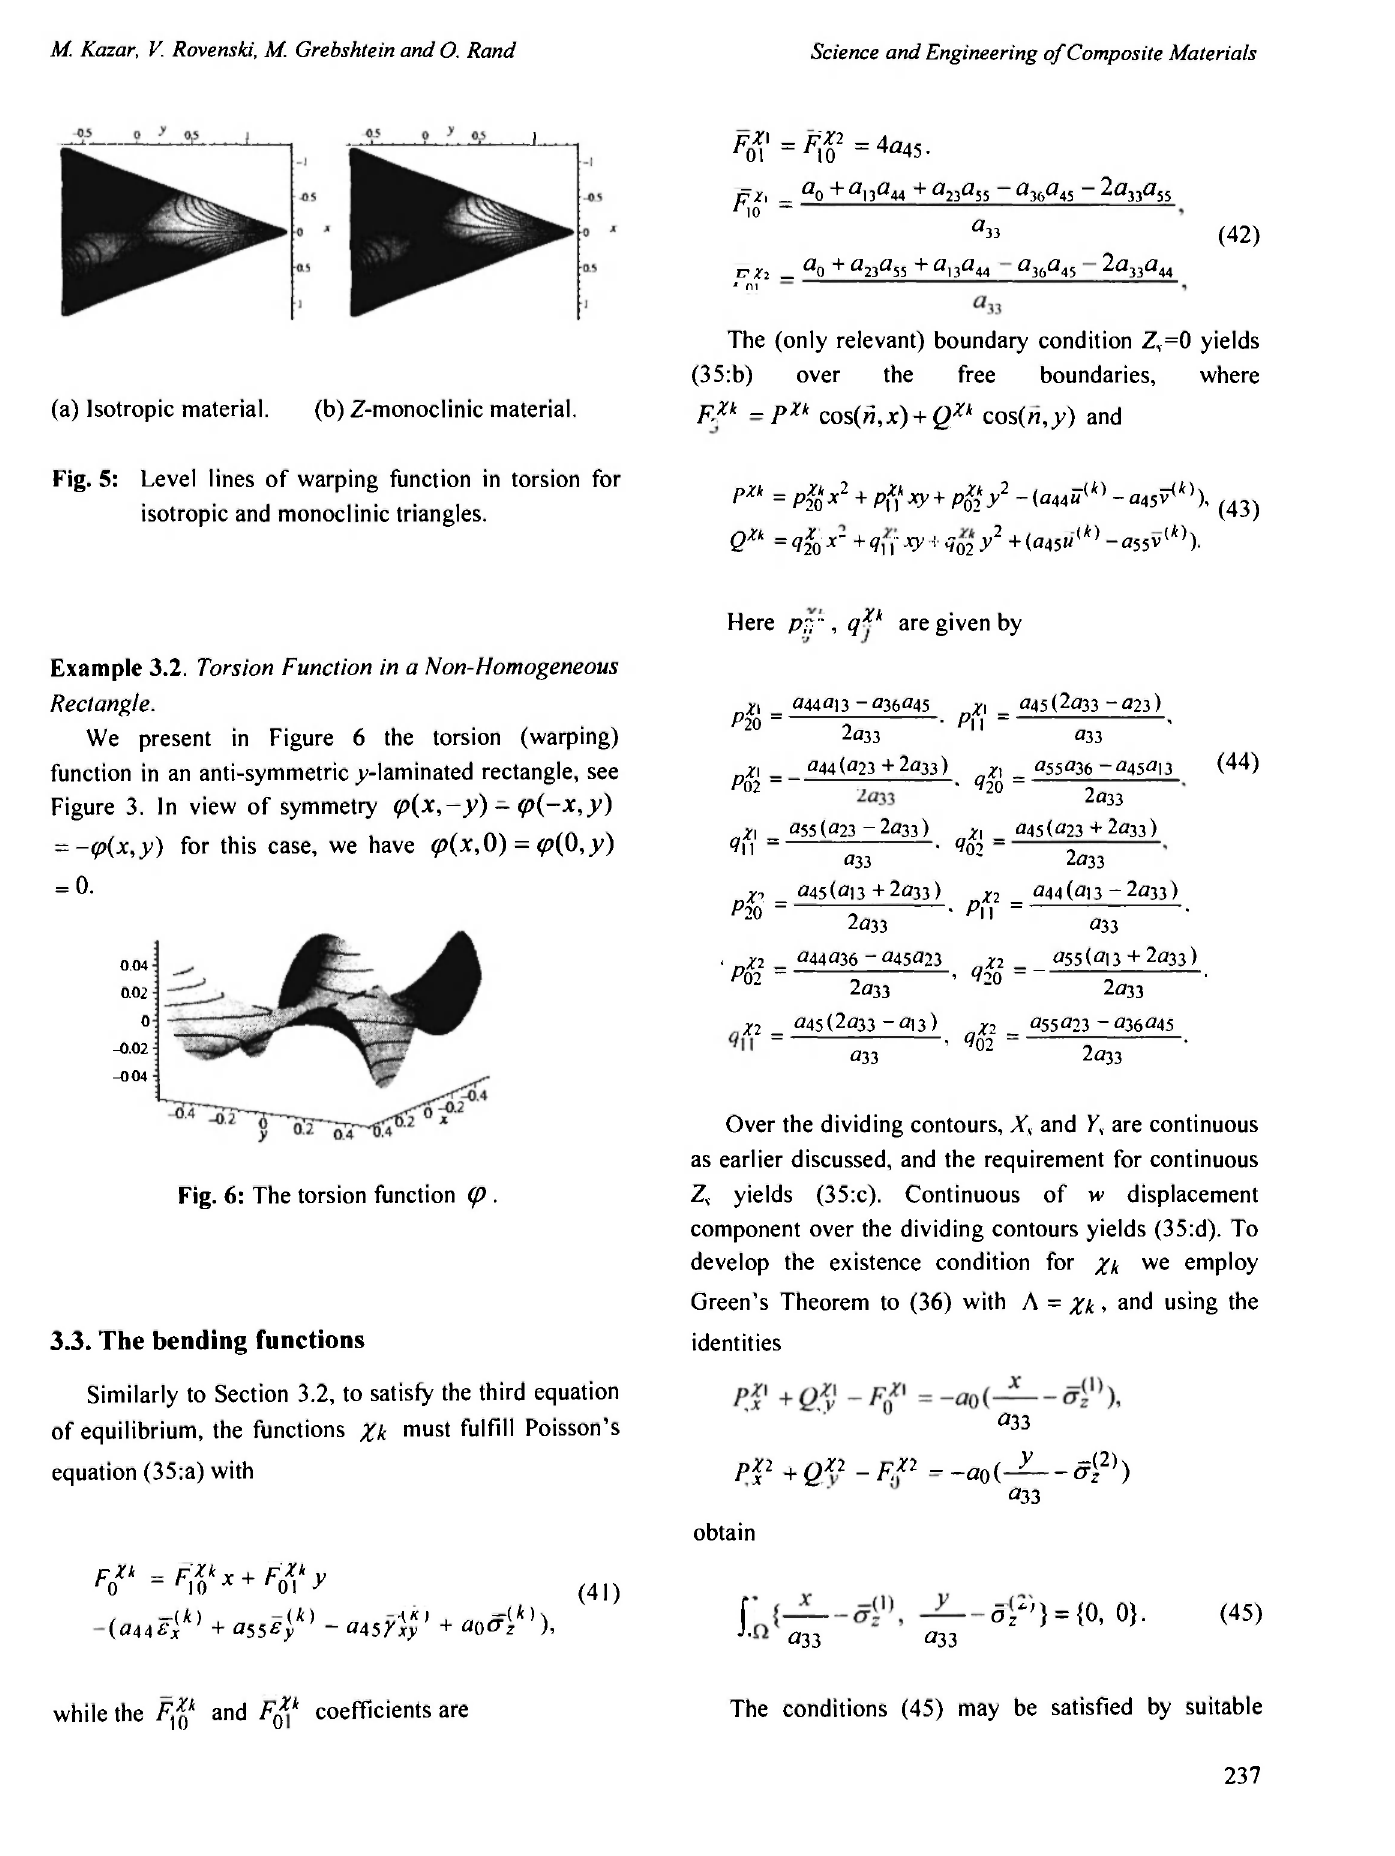
Fig. 6: The torsion function φ